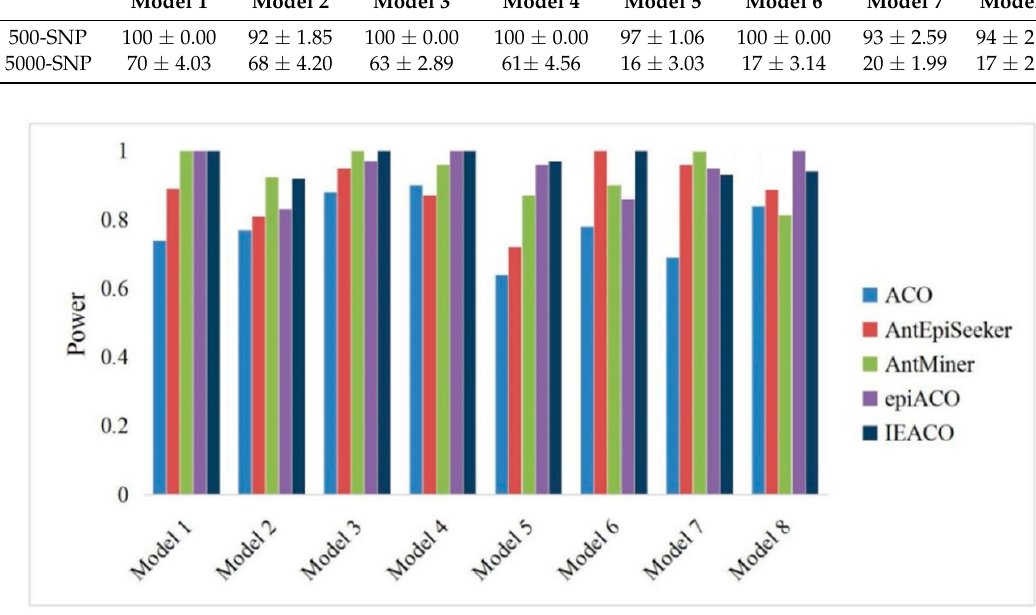
Figure 3. Power comparison on 500-SNP datasets.